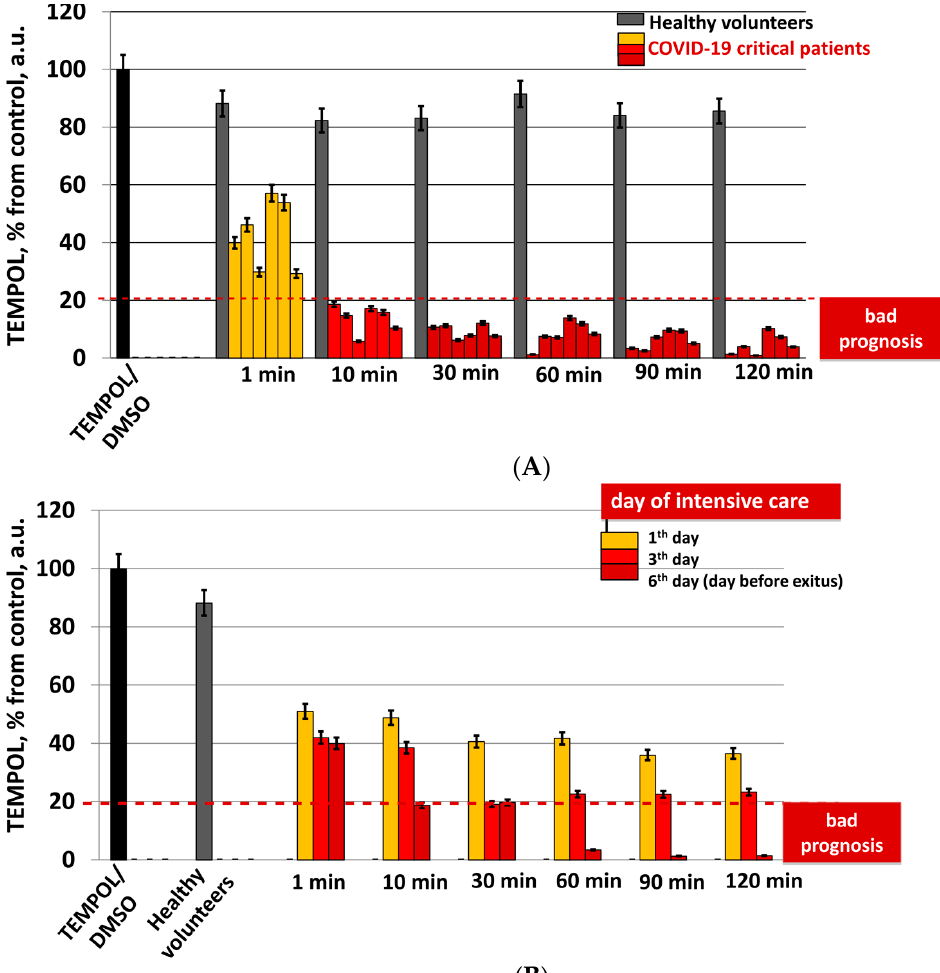
Figure 5. Double-integrated area of stable nitroxide radical TEMPOL in severe COVID-19 patients. The results are presented as an average of three independent measurements (mean ± SE) for each different time interval: 1 min to 120 min. The double-integrated EPR spectra of healthy volunteers (in gray) are presented as the mean ± SE from six healthy volunteers. ( A ) double-integrate EPR spectra of TEMPOL in serum samples from severe COVID-19 patients and healthy volunteers (in gray). Results are presented as the percent value of control TEMPOL/DMSO. ( B ) Double-integrated EPR spectra of TEMPOL: serum samples from COVID-19 patients (1st day of intensive care—yellow, 3rd day in red, and 6th day in dark red) and healthy volunteers (in grey). Results are presented as the percent value of control